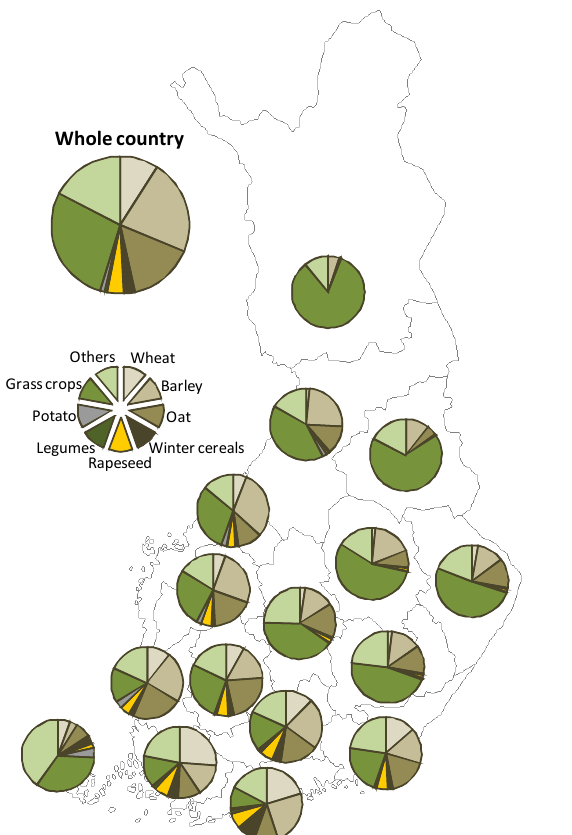
Fig. 5. Regional differences in land use in crop production in 2011 (Data from Tike). Regions, see Figure 1.